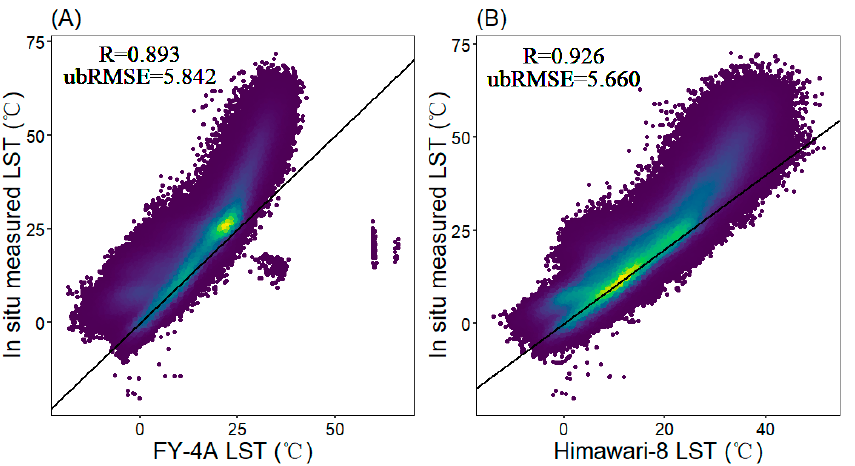
Figure 3. Scatterplots of FY-4A LST and Himawari-8 LST vs. in situ measurement; the straight line in the figure is the y = x line; the brighter the color in the figure, the more concentrated the data